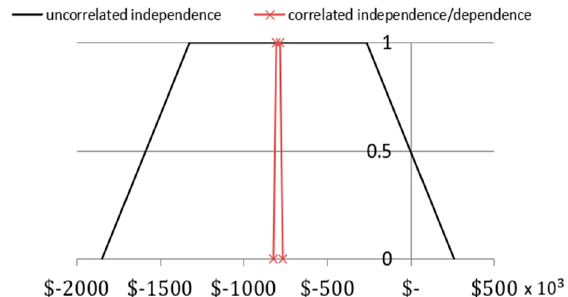
Figure 4. Independence case of difference of scenarios B and C.